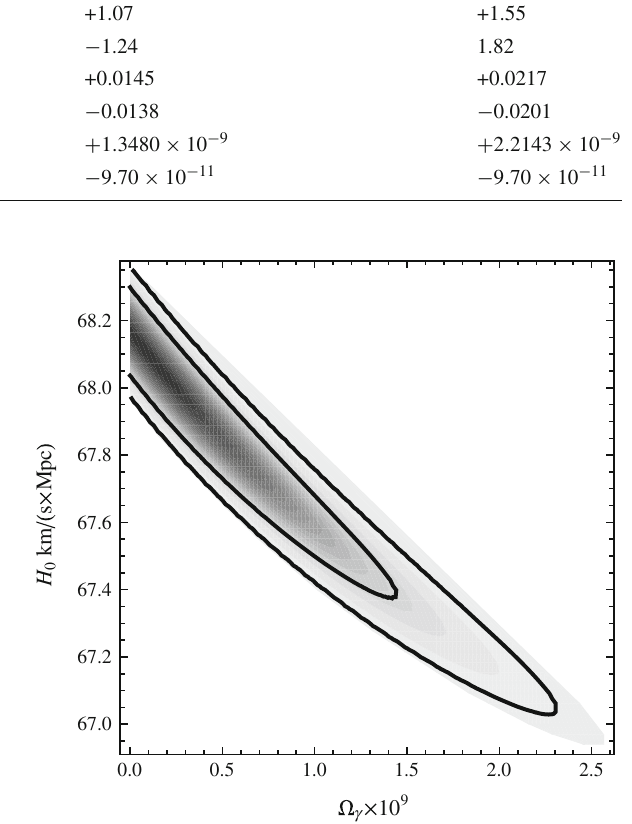
Fig. 18 The intersection of the likelihood functions of two model parameters ( (cid:3) γ , H 0 ) with the marked 68 and 95% confidence